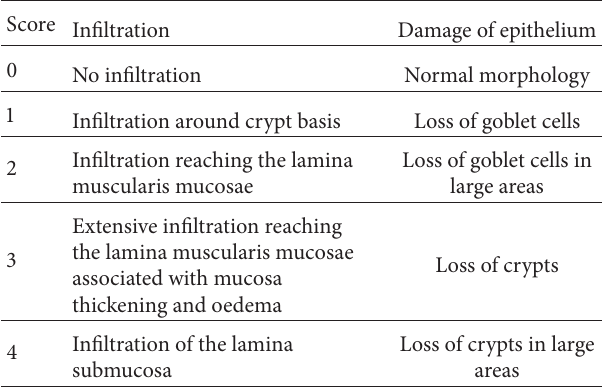
Table 2: Histological scoring ∗